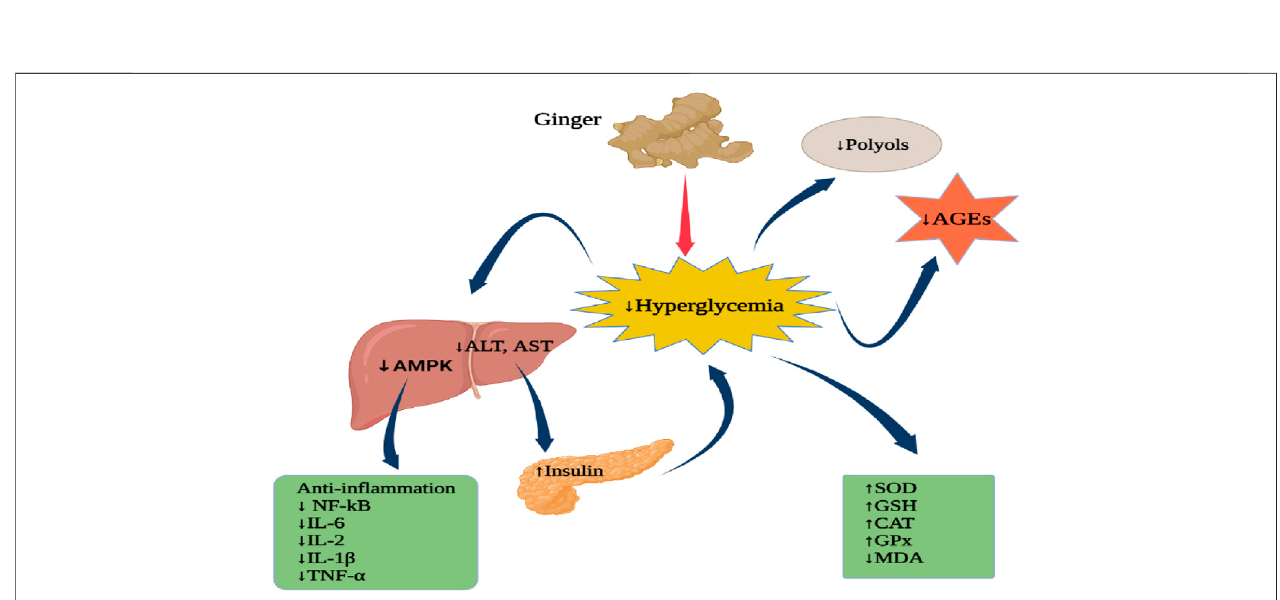
FIGURE 6 | Anti-diabetic actions of ginger. AMPK, Mitogen-activated protein kinase; ALT, Alanine aminotransferase; AST, Aspartate aminotransferase; AGEs, Advancedglycationend-products;NF-kB,nuclearfactorkappaB;IL-6,Interleukin-6;IL-2,Interleukin-2;IL-1 β ,Interleukin-1beta;TNF- α ,Tumournecrosisfactor-alpha; SOD, Superoxide dismutase; GSH, glutathione; CAT, Catalase;GPx, Glutathione peroxidase, MDA, Malondialdehyde. Figurewas created using BioRender.com by the authors.